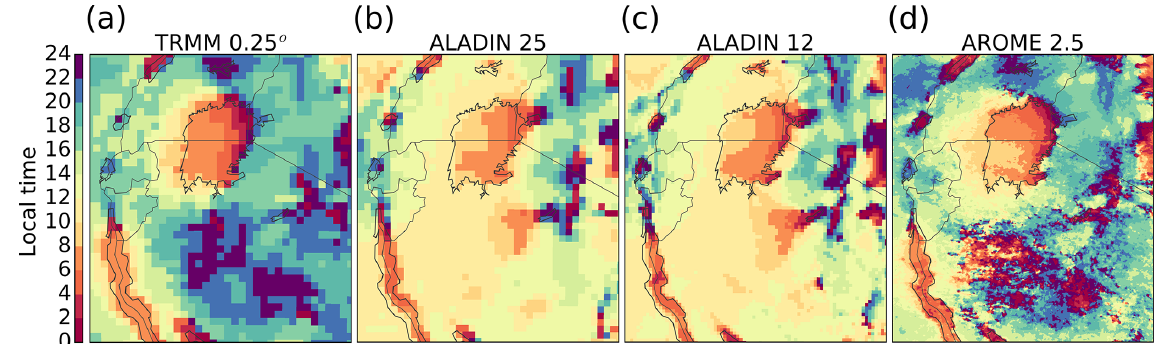
Figure 10. Time (local mean time) of maximum precipitation intensity during the diurnal cycle around Lake Victoria (2006) for (a) TRMM with 0.25 ◦ resolution, (b) ALADIN with 25km resolution, (c) ALADIN with 12km resolution and (d) AROME with 2.5km resolution. The time of maximum precipitation is based on a cubic spline fitted to the 3h precipitation, and only days with more than 1mmd − 1 are included (see Nikulin et al., 2012, for details). The AROME simulation was forced by the ALADIN 12km simulation shown in (c)